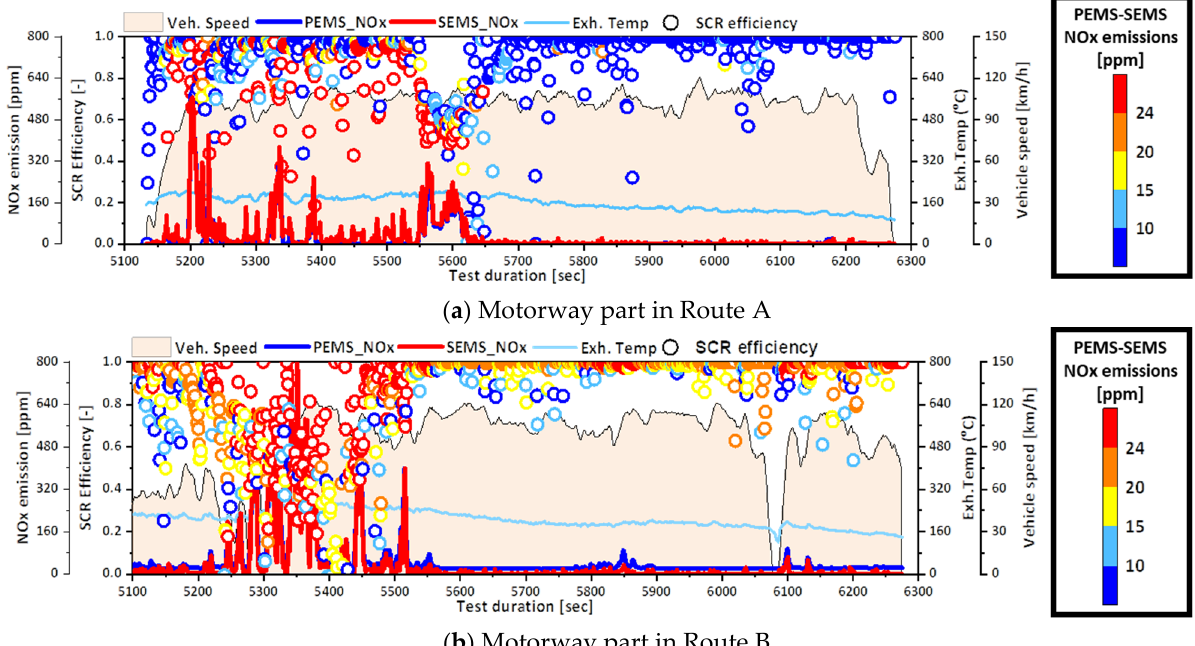
Figure 21. Real-time profiles of SCR efficiency and the difference between NOx emissions measured by the PEMS and SEMS equipment under motorway part in Routes A and B.